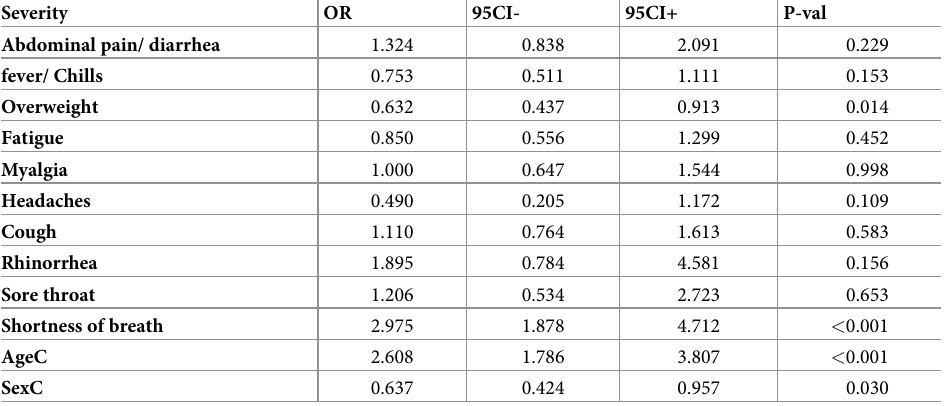
Table 6. Binomial logistic regression coefficients of various factors predicting intubation from joint symptoms as